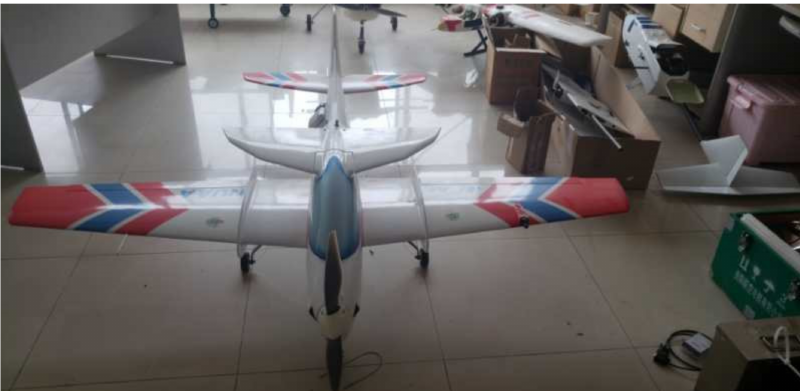
Figure 11. UAV flatform for passive transducers.